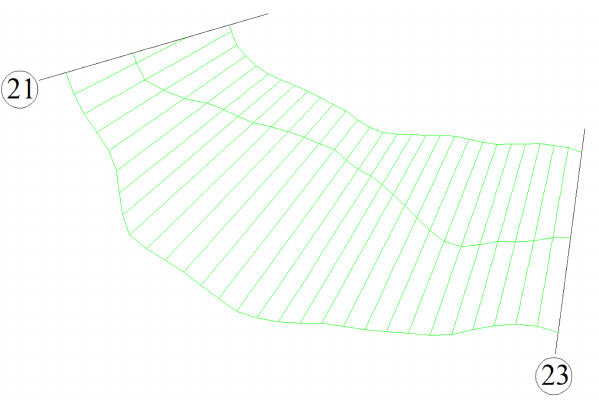
Figure 4. Preliminary generation result of quadrilateral grids (In the exemplified preliminary grid generation, the fixed number segmentation method is applied to the riverway